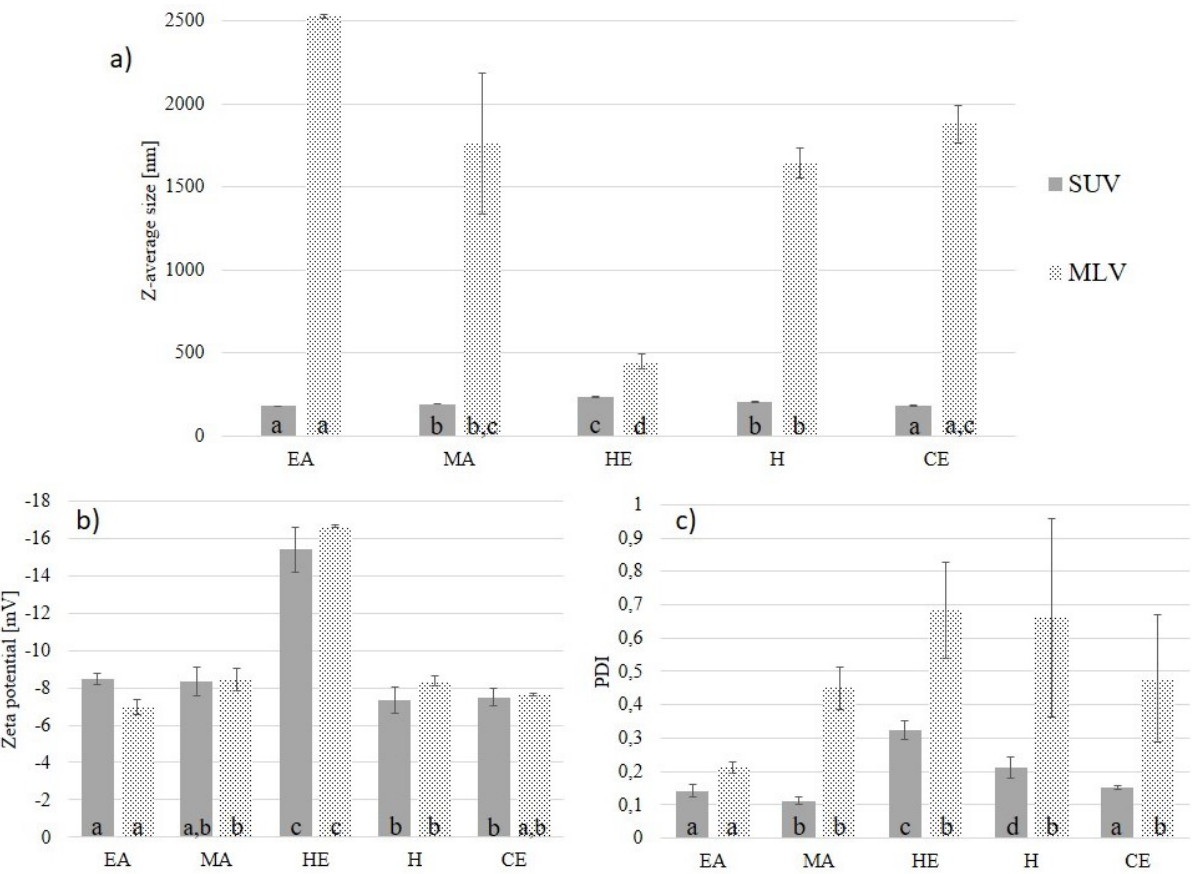
Figure 1: Dynamic light scattering and Zeta potential of liposomes measured directly after preparation: (a) Z-average size [nm]; (b) Zeta potential [mV]; (c) PDI. Bars bearing different superscripts are statistically, significantly different